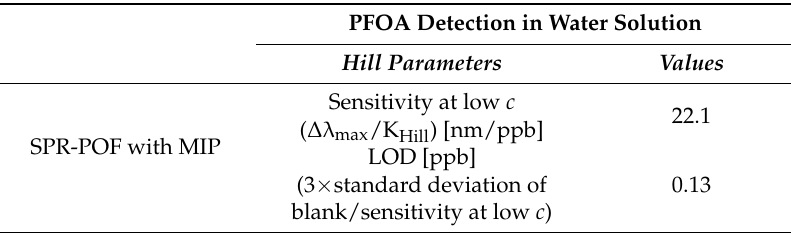
Table 4. Chemical parameters (SPR-POF sensor).